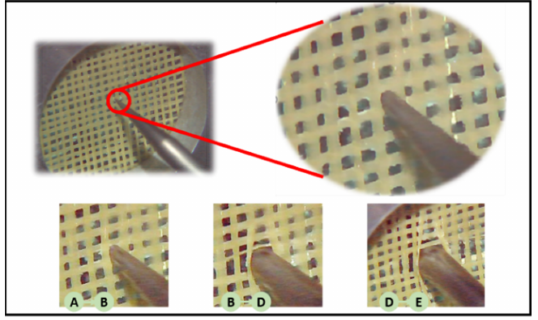
Figure 10. The composite puncture experiment. (The three pictures AB, BD, and DE in the figure correspond to the three stages in Figure 11).